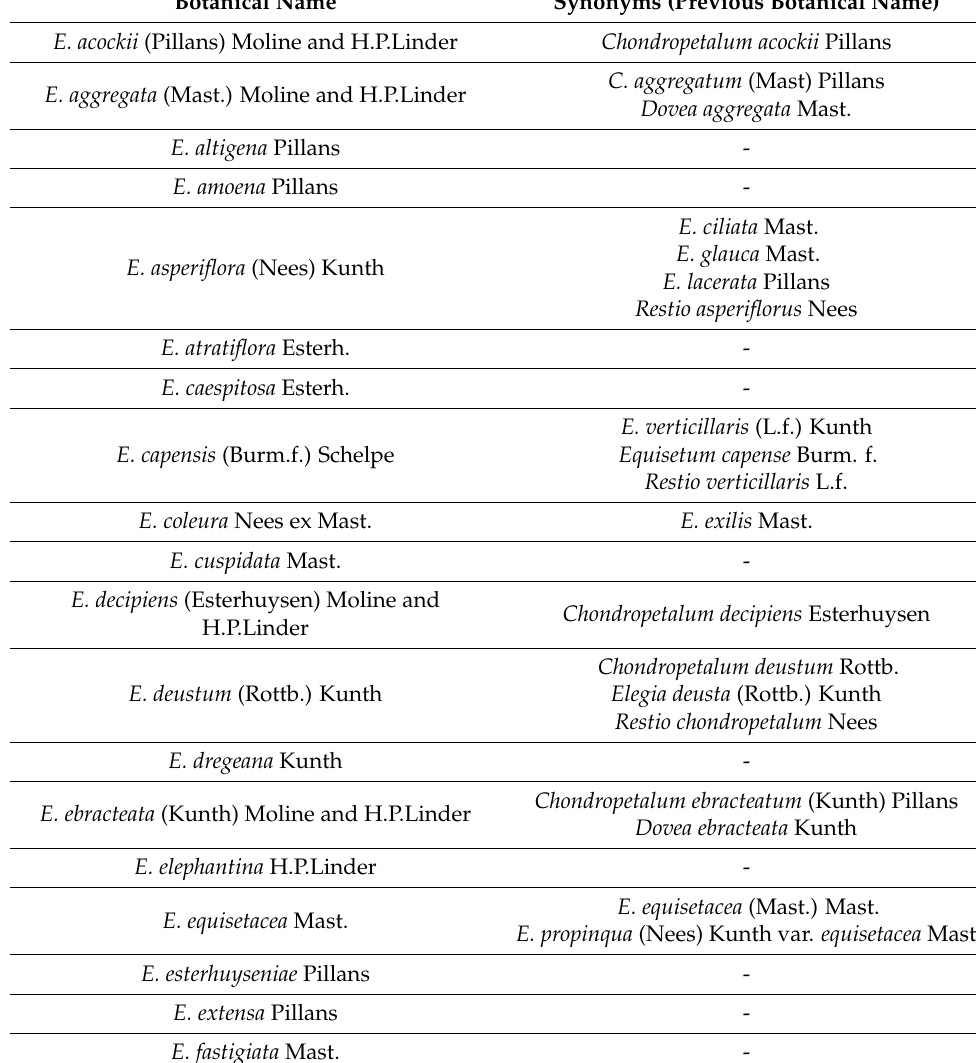
Table 2. All species of the genus Elegia L. and their previous botanical names. Botanical